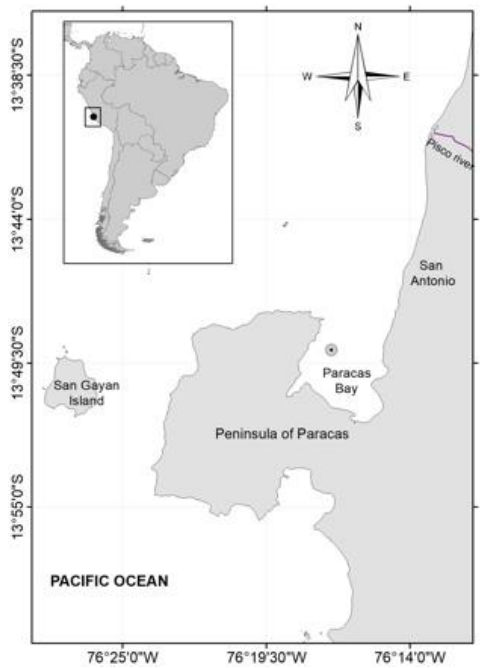
Figure 1. Map Paracas Bay, Peru (13 ° 49 ′ S, 76 ° 17 ′ W). P. cordatum cells were isolated under an inverted phase contrast microscope (NIKON, eclipse TS100, Tokyo, Japan), with the technique of cell washing with micropipettes